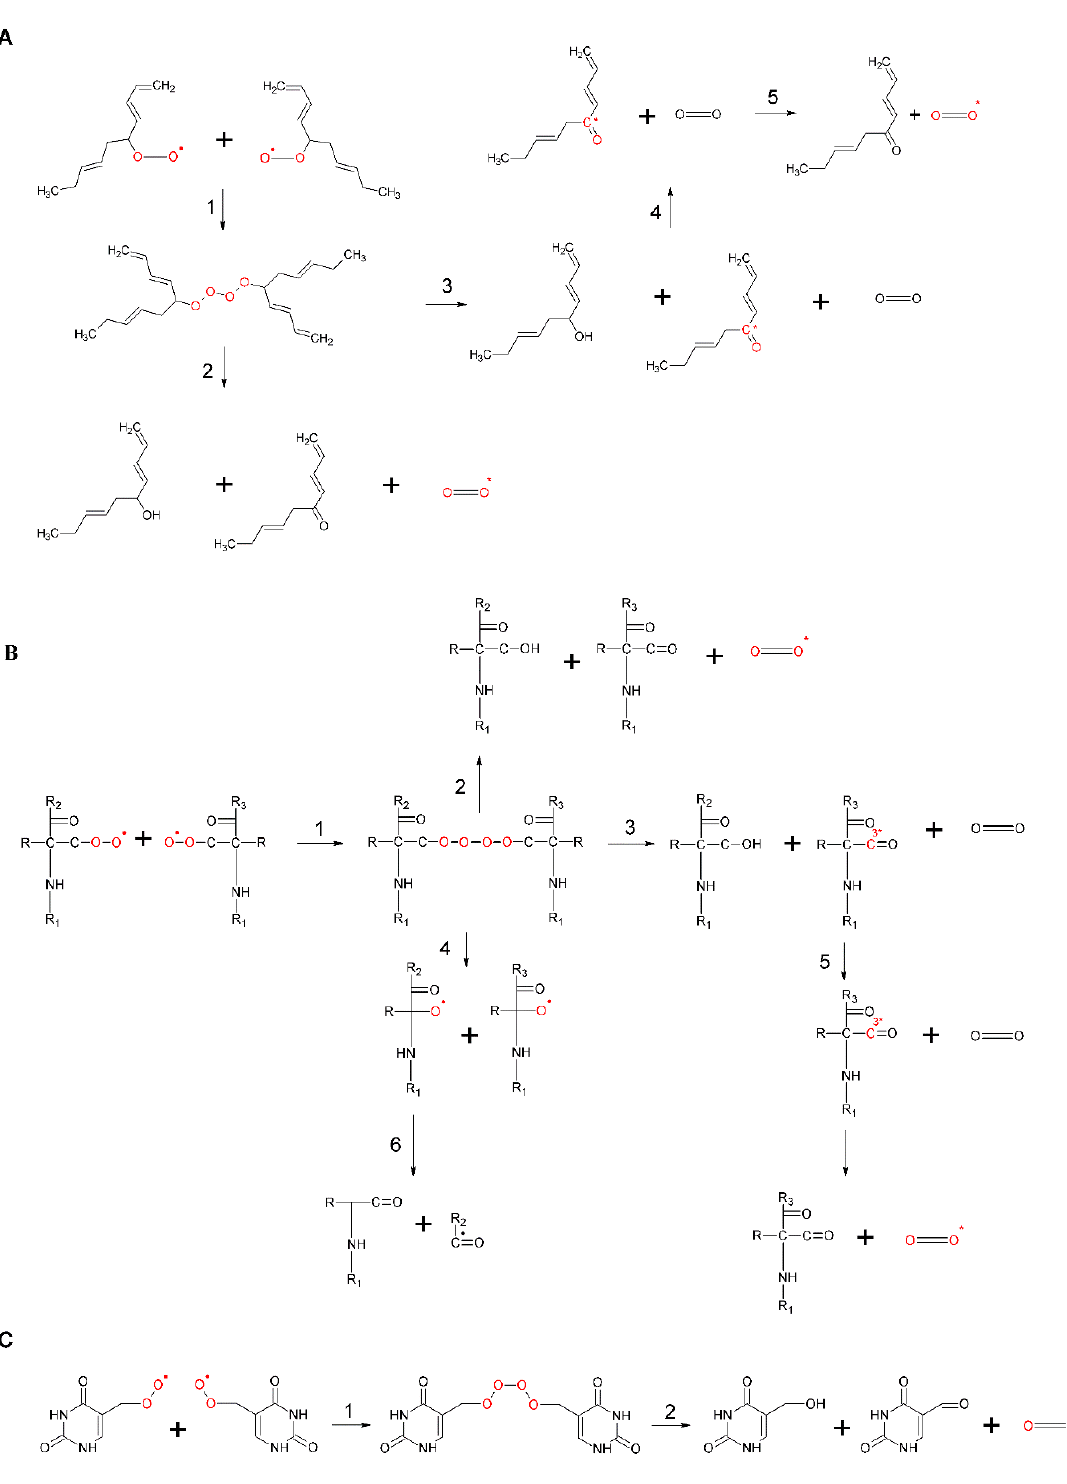
Figure 6. Formation of ROOOOR by the recombination of two lipid ROO • ( A ), protein ROO • ( B ), and DNA ROO • ( C ). In ( A – C ), the recombination of two ROO • results in the formation of unstable ROOH (reaction 1). ROOH can decompose either to ground carbonyl, 1 O 2 and ROH (reaction 2) or to 3 R = O * , molecular oxygen and ROH (reaction 3). The triplet-singlet energy transfer from 3 R = O * to molecular oxygen causes the formation of 1 O 2 (reactions 4). In ( B ), ROOH can decompose into two RO • in the presence of reducing agents (reaction 5).